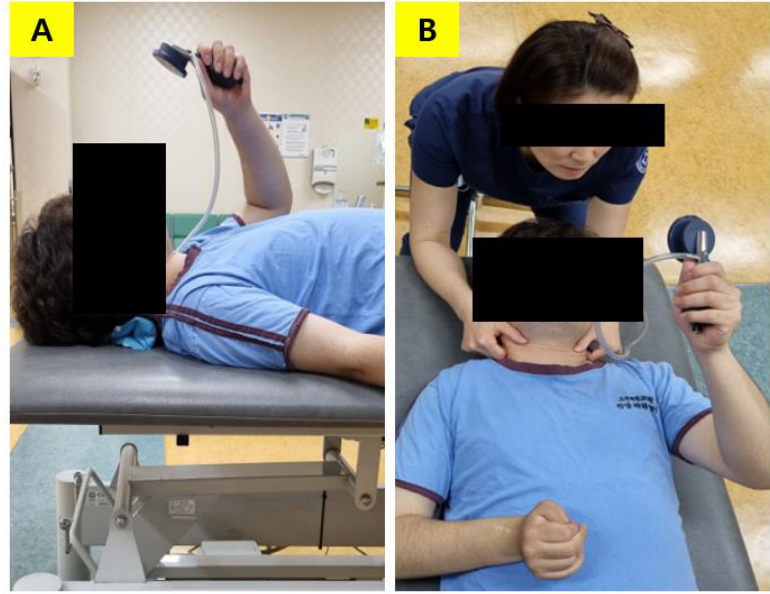
Figure 1. Contraction of deep neck flexor muscle progression. ( A ) The patient's head and neck position using a pressure biofeedback device. ( B ) Bilateral contraction in supine. 2.3. Measurement